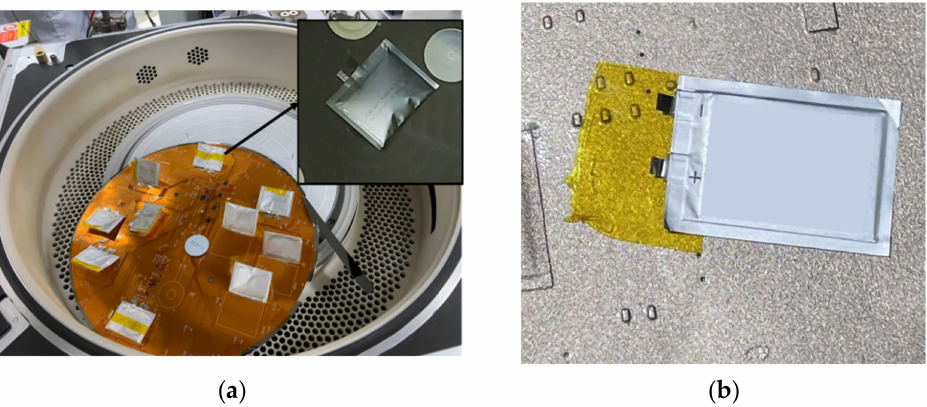
Figure 4. Results of operation test in a vacuum. ( a ) OTMS damaged due to the expansion of lithium polymer type battery, ( b ) semi-solid type battery vacuum test.